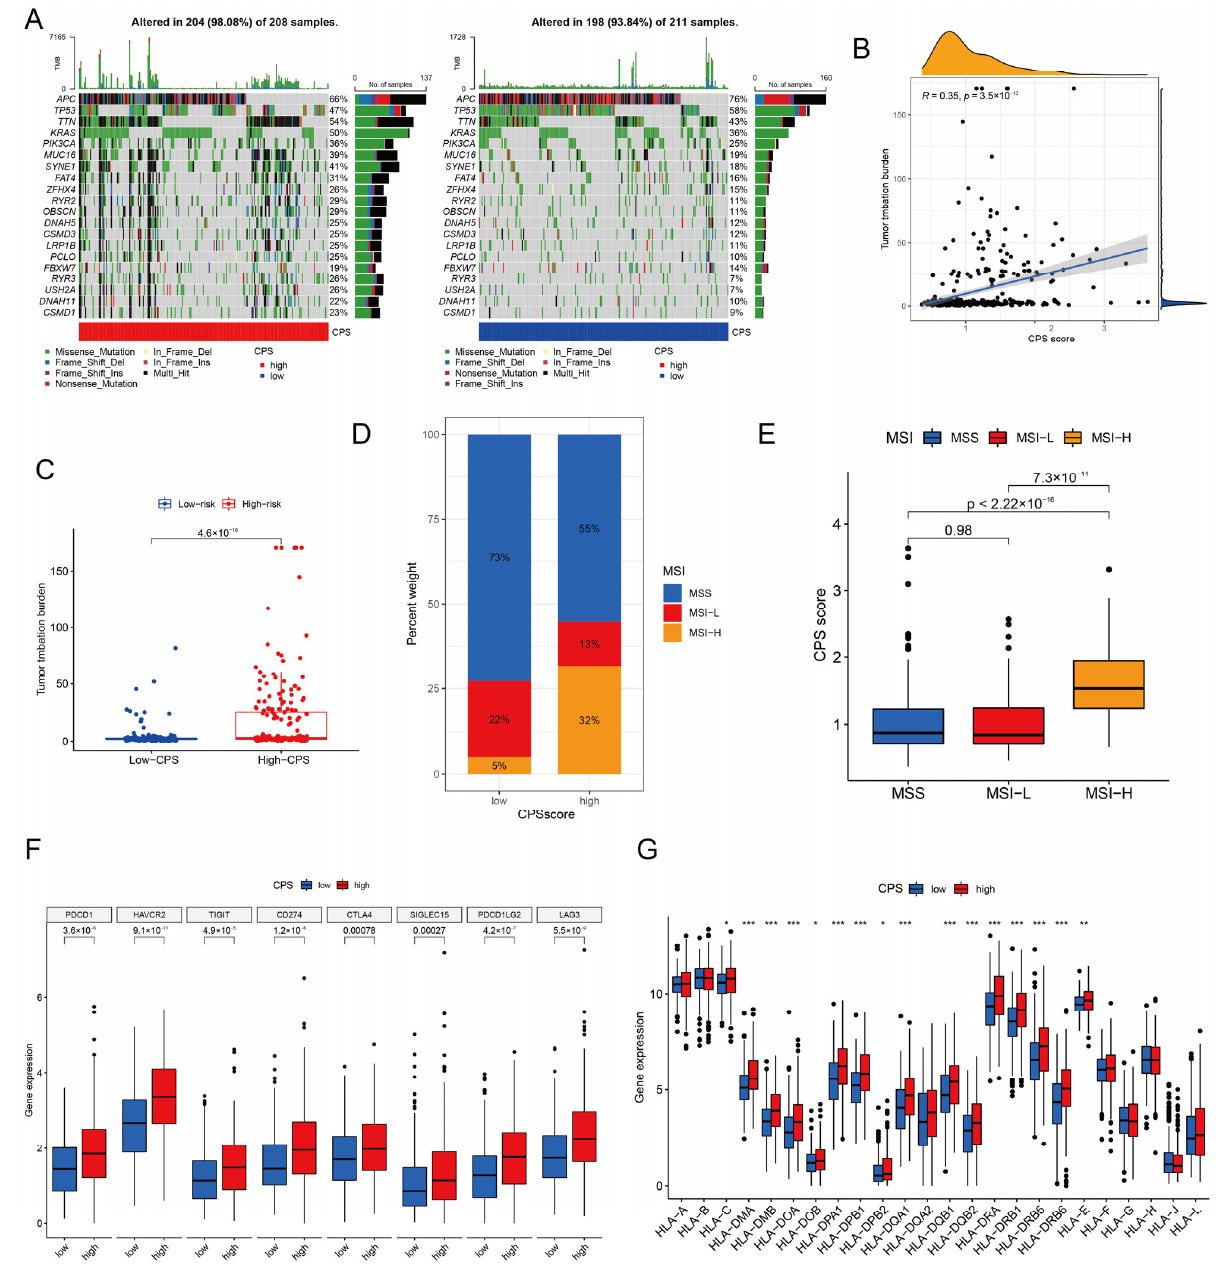
Figure 7. Immunotherapy response analysis of CPS score. ( A ) Waterfall plot of tumor somatic mutations in diverse CPS-score subgroups. ( B ) Correlation between CPS score and TMB. ( C ) Relative distribution of TMB between the high and low CPS-score groups. ( D ) MSI characteristics of the diverse CPS-score subgroups. ( E ) Differences in CPS score between MSS, MSI-L, and MSI-H. ( F ) Differences in ICB expression between diverse CPS-score subgroups. ( G ) Differences in expression of HLA-related genes between high and low CPS-score groups. TMB, tumor mutation burden; MSI, microsatellite instability; MSS, microsatellite stability; MSI-L, low-frequency MSI; MSI-H, high-frequency MSI; ICB, immune checkpoint blockade; HLA, human leukocyte antigen. * p < 0.05; ** p < 0.01; *** p <